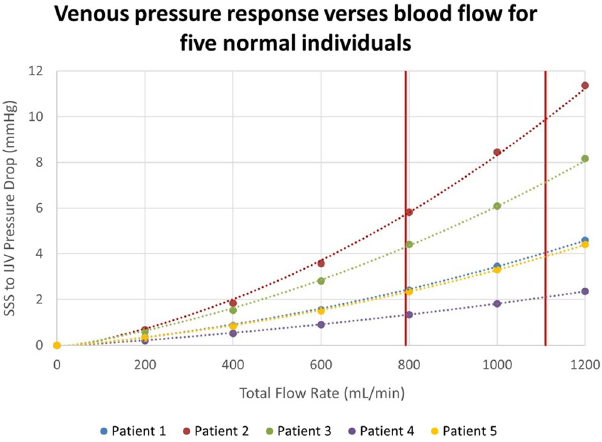
Fig. 1 Venous pressure vs. blood fl ow. A graph of the venous pressure response vs. blood fl ow for the fi ve patients modelled in reference 69 . The two vertical lines represent the normal fl ow rate at middle age on the left (792 mls/min) and a 40% increase in fl ow on the right (1110 mls/min). Note the pressure drop across the venous system is close to the normal fi gure of 2.5 mmHg at a normal fl ow rate for 3 of the 5 patients but elevated in 2. At a fl ow rate of 1110 mls/min there is a wide variation in response meaning there is a variable risk for the development of SANS if this condition is analogous to IIH. IVJ internal jugular vein, SSS superior sagittal